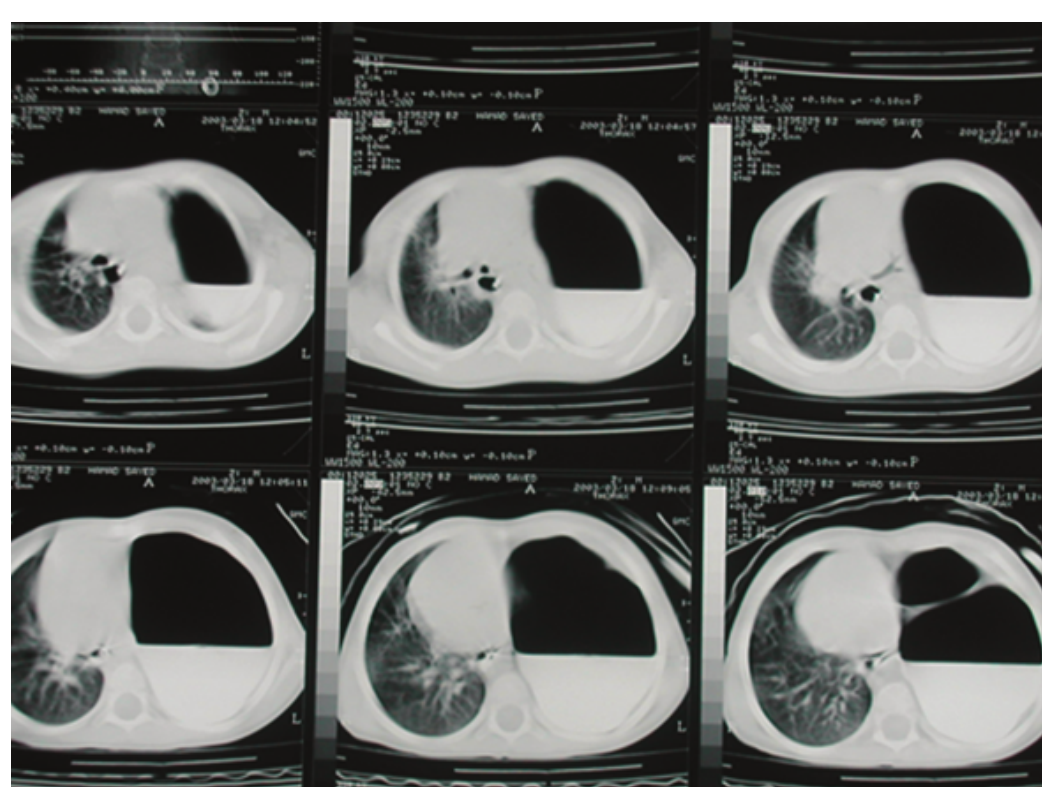
Figure 3: CT scan chest with contrast before